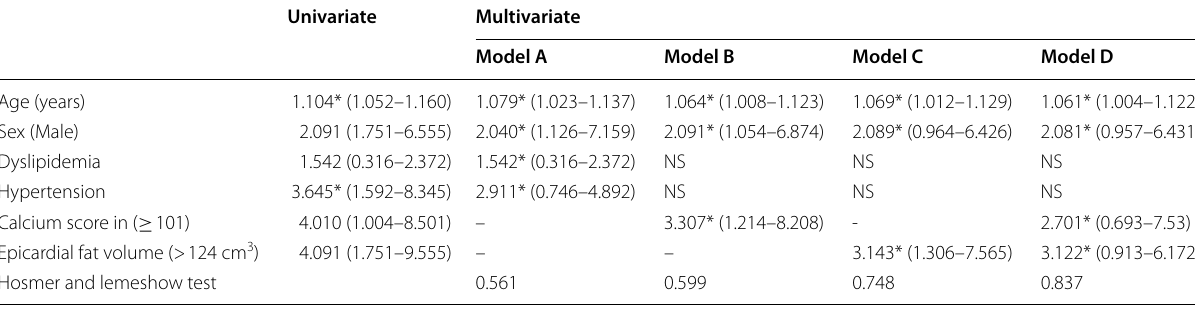
Table 8 Univariate and multivariate Logistic regression analysis for the parameters affecting an event (obstructive coronary artery disease 50%) vessel stenosis ( n 60 vs. 60) ≥ =